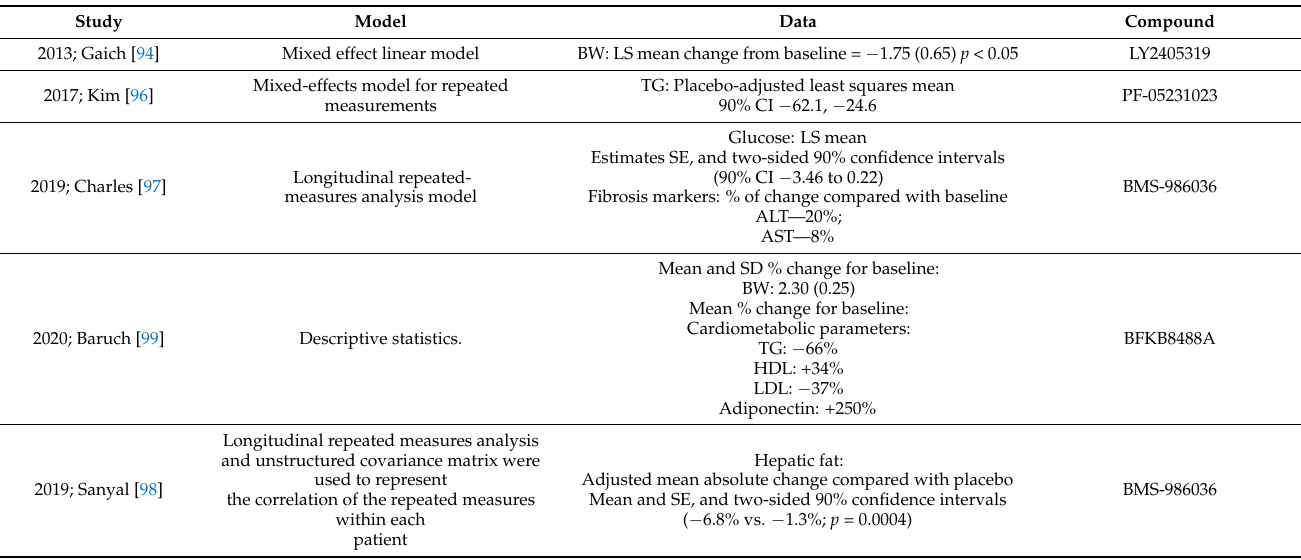
Table 2. Quality synthesis: ANCOVA: analysis of covariance; ALT: alanine aminotransferase; AST: as- partate aminotransferase; BW: body weight; FGF21:Fibroblast growth hormone 21; HDL: high